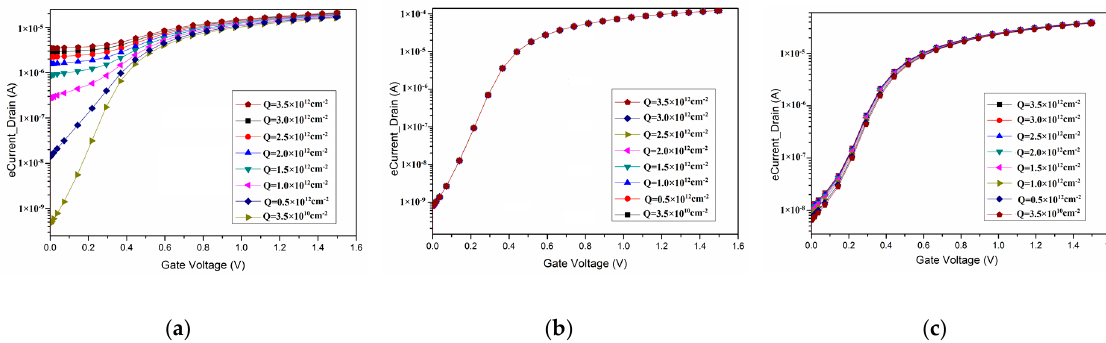
Figure 2. The simulation results of the I d - V g curve of ( a ) the single gate layout, ( b ) the enclosed gate layout, and ( c ) the Z gate layout.